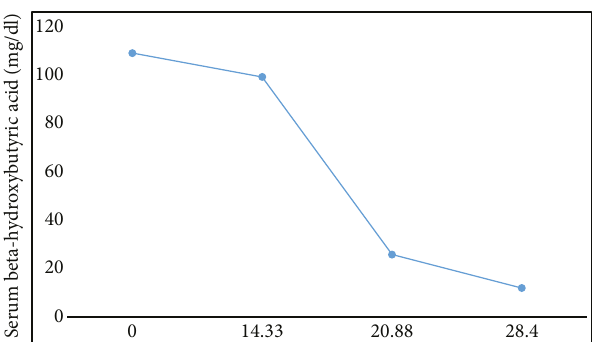
Figure 1: Trend of serum beta-hydroxybutyric acid level during